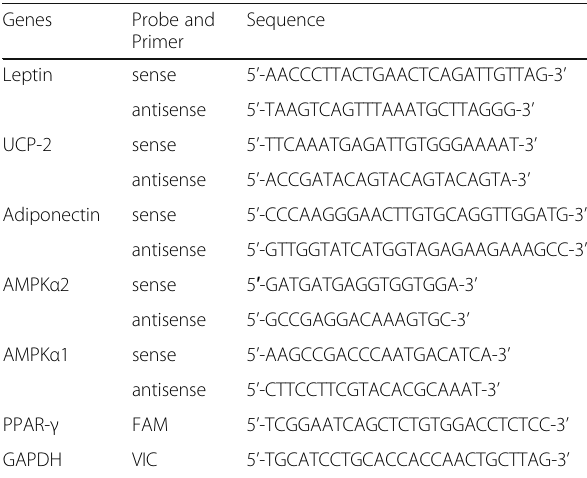
Table 1 The primer and probe sequences used in the real-time RT-PCR analysis